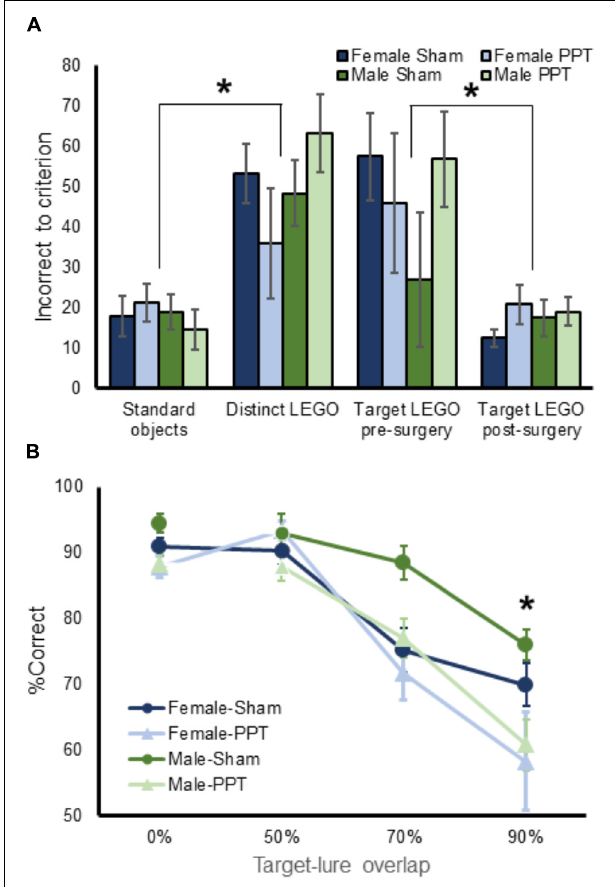
FIGURE 3 | Performance on object discrimination tasks by experimental group. (A) Shows the mean number of incorrect trials made prior to reaching criterion performance on all pre-training object discrimination problems for female (blue) and male (green rats) in the Sham (dark) and PPT (lighter) groups. There were no significant groups differences across training problems. (B) Mean percent corrent on target-lure discrimination as a function of overlap. Rats performed significantly worse as target-lure similarity increased ( F [ 3 , 78 ] = 61.43, p = 0.0001). Moreover, the PPT group performed significantly worse compared to the sham group ( F [ 1 , 26 ] = 8.80, p = 0.006), and the interaction between target-lure similarity and experimental group was statistically significant ( F [ 3 , 78 ] = 3.02, p = 0.035). Post hoc comparison indicated that the PPT rats made significantly more errors compared to sham animals on the 90% overlap lure object discrimination (corrected α = 0.05/4 = 0.0125, T [ 28 ] = 2.74, p = 0.011). There was no overall main effect of sex on performance ( F [ 1 , 26 ] = 2.51, p = 0.13). Error bars are ± 1 Standard error of the mean (SEM). ∗ Indicates significant effect.